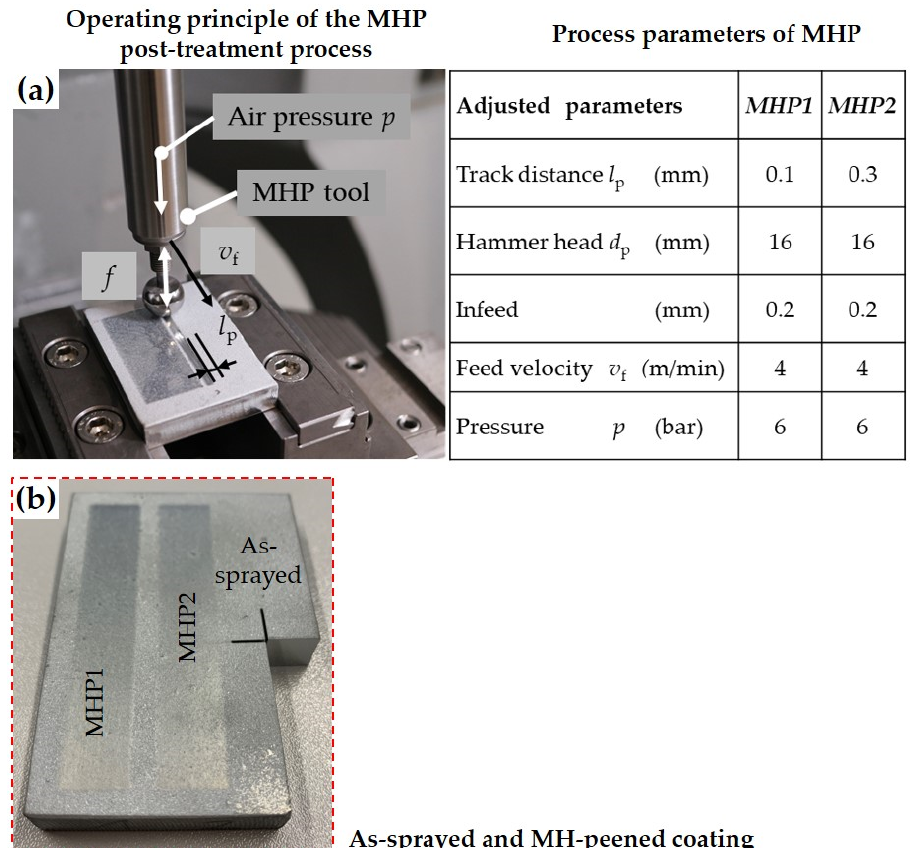
Figure 1. Machine hammer peening (MHP) post-treatment and the adjusted process parameters. ( a ) pictorial schematic of MHP process, ( b ) MH-peened specimen. The evaluated responses in the full-factorial plan are the coating thickness, porosity, mean roughness depth Rz, induced residual stress, and hardness. The roughness of the